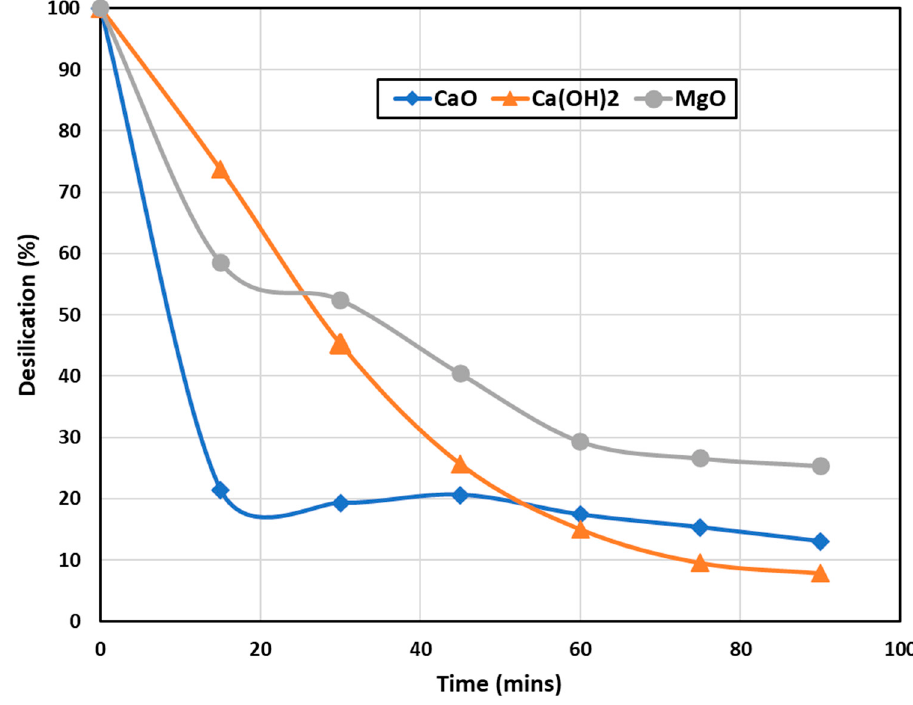
Figure 6. Percentage reduction of Si with time using 6 g of CaO, Ca(OH) 2 , and MgO at 90 °C for 90 min.